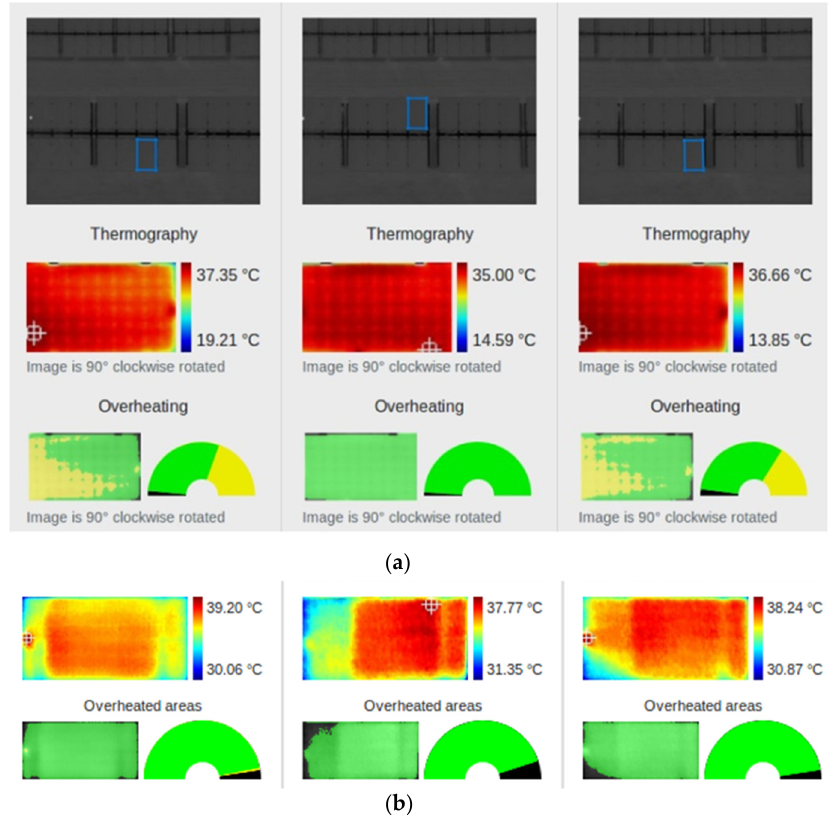
Figure 14. ( a ) Three IR images acquired by the IR-camera on board the UAV and the temperature distribution. ( b ) Temperature distribution of the same PV modules by means of a manual IR camera.